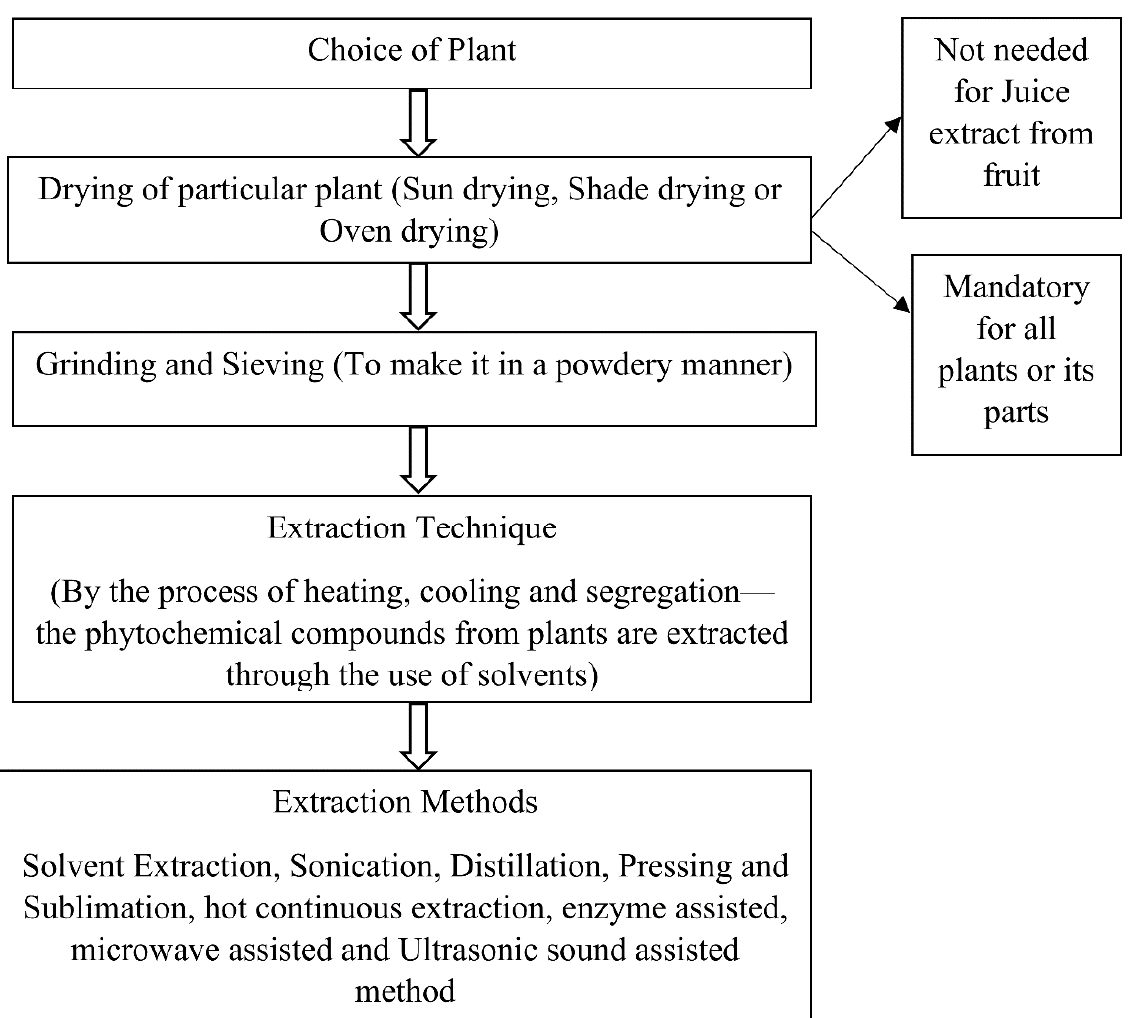
Figure 7. Schematic diagram of extraction procedure of phytochemicals.